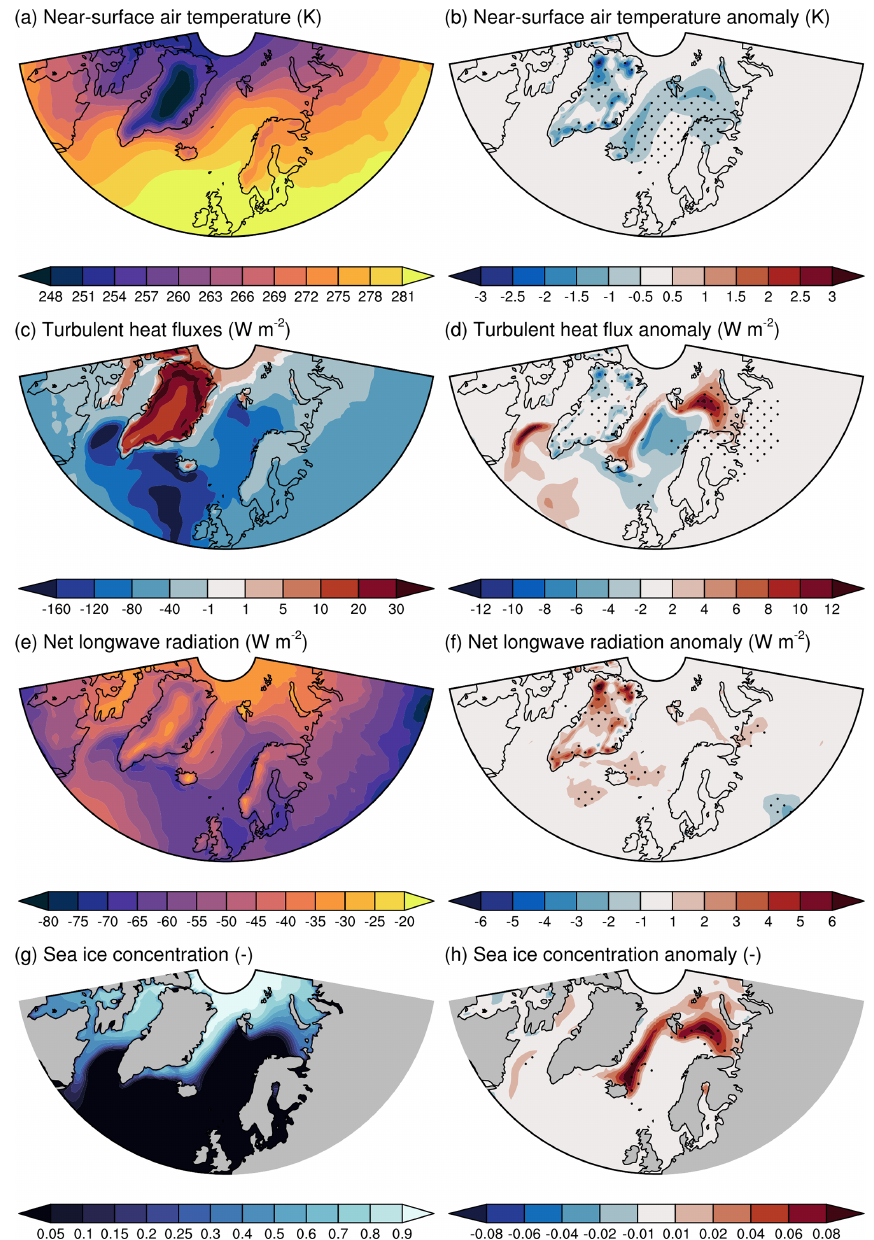
Figure 5. Annual climatology (1965–2005) of EC-1K (left column) and anomalies of EC-6K with respect to EC-1K, which approximate the EC imprint (right column). (a, b) Near-surface air temperature (K), (c, d) turbulent (sensible+latent) heat fluxes (Wm − 2 ), (e, f) net longwave radiation (Wm − 2 ), and (g, h) sea ice concentration (–). Black dots indicate significance at the 95% level according to a Student t test. Positive signs for (a–f) indicate energy transfer from atmosphere to the